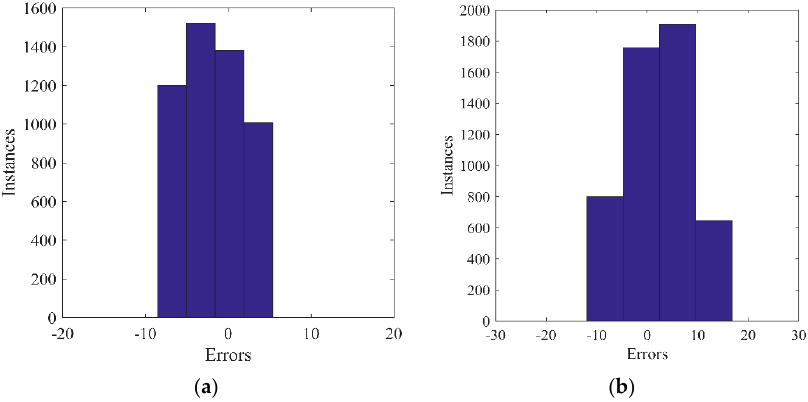
Figure 7. Comparison of output force between experimental and BPANN predicted results: ( a ) A = 0.05 mm; ( b ) A = 0.15 mm.